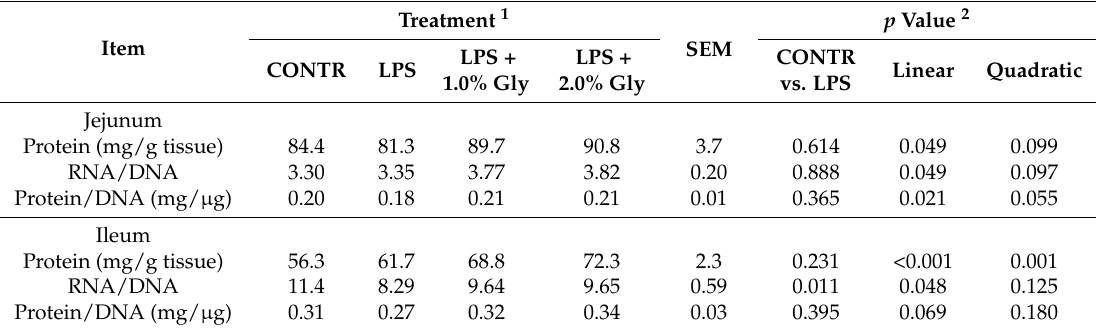
Table 2. Effect of glycine supplementation on intestinal protein, DNA and RNA contents after 4 h LPS challenge in